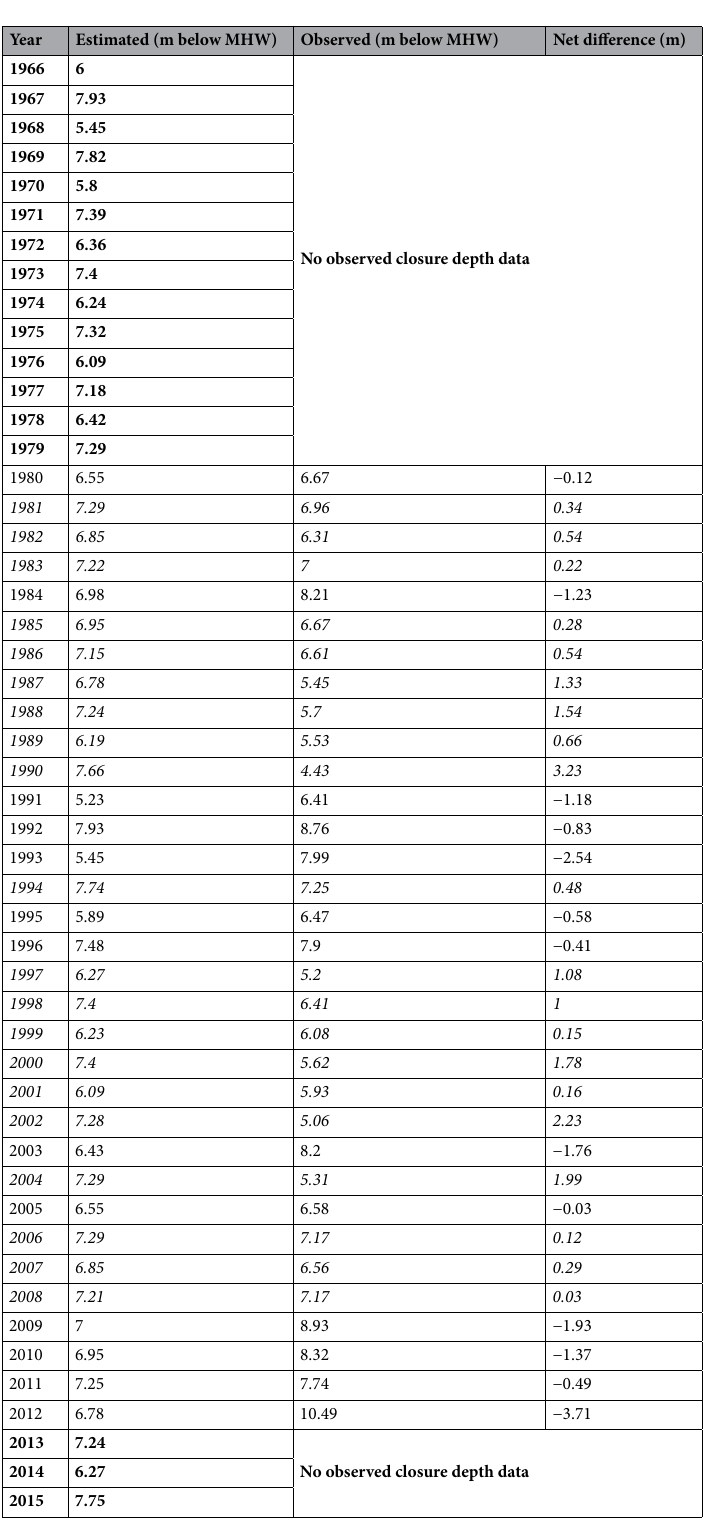
Table 6. Closure depth time series estimates used to hindcast meso timescale shoreline evolution (1966–2016) compared against associated observations. Net difference (m) = estimated − observed closure depth. Bold rows indicate non-verifiable closure depth estimations, italics rows indicate closure depth overestimation, and non- highlighted rows indicate closure depth